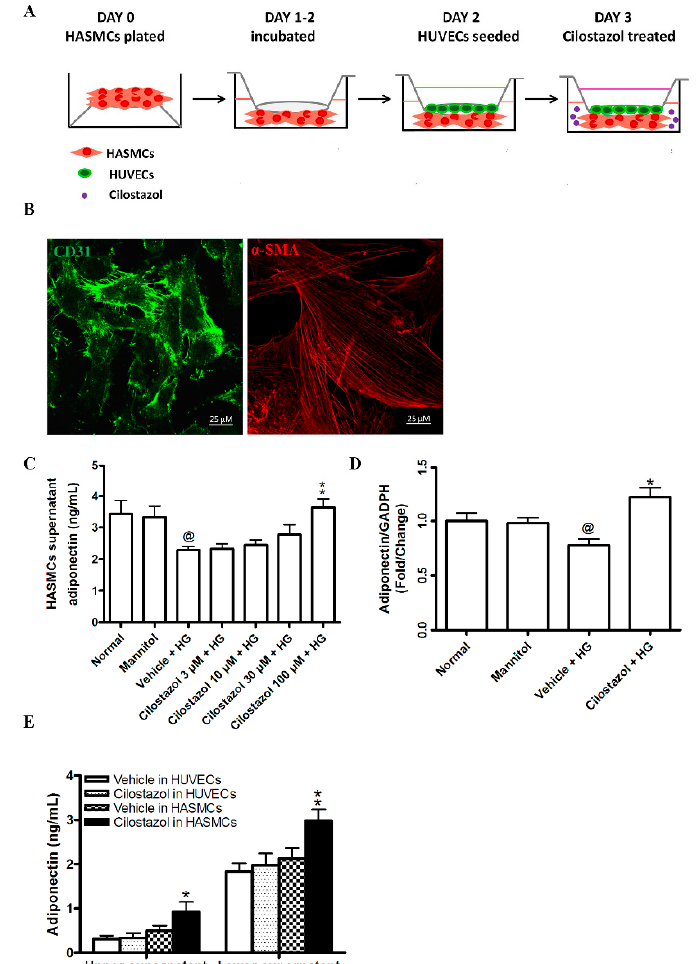
Figure 1. Cilostazol increased adiponectin levels in HUVECs by stimulating HASMC production under HG conditions. ( A ) Schematic diagram of the Transwell coculture system. HUVECs were seeded in the upper chamber, and HASMCs were cultured in the lower chamber under HG (25 mmol/L) conditions. ( B ) Representative images of immunostaining of HUVECs with CD31 (green) and HASMCs with α -SMA (red). Scale bar: 25 µM. ( C ) Quantification of adiponectin levels in the supernatants of the lower insert using ELISAs. Mannitol was used as an osmolality control. ( D ) Quantification of adiponectin expression in HASMCs using real-time PCR. ( E ) Quantification of adiponectin levels in the cilostazol-treated coculture system under HG conditions using ELISAs. The results are represented as the mean ± S.E.M. from three independent experiments. @ p < 0.05 versus the normal group; * p < 0.05 and ** p < 0.01 versus the vehicle group.